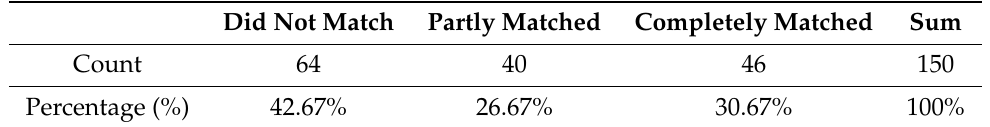
Table 4. Results on 150 documents tested manually on held-out test